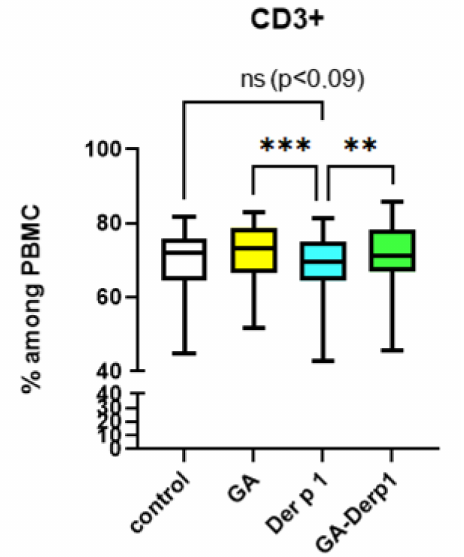
Figure 6. The relative number of CD3+ cells after cultivation with GA–Der p 1 complex. Data are presented as box-and-whisker plots, with boxes extending from the 25th to the 75th percentile, with a horizontal line at the median, while the whiskers extend to the lowest and highest data points (n = 10); ** indicates a significant difference ( p < 0.01); *** indicates a significant difference ( p <